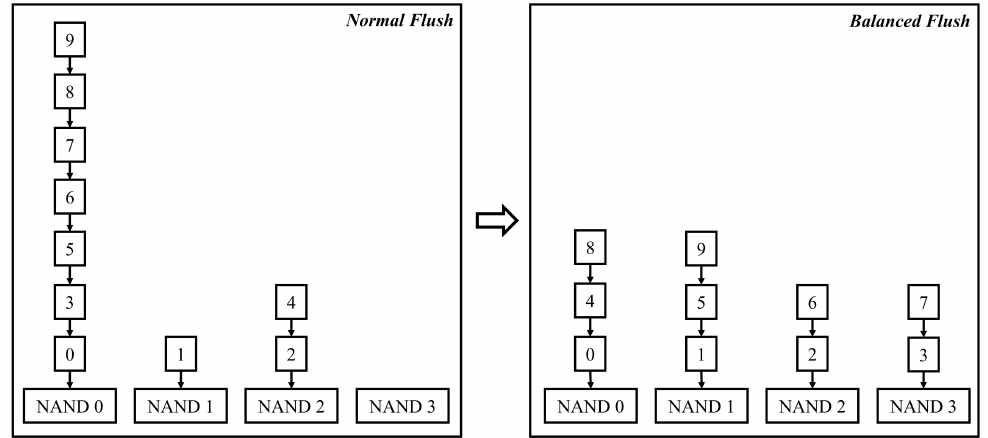
Figure 8. Comparison of normal and balanced flush in case of power